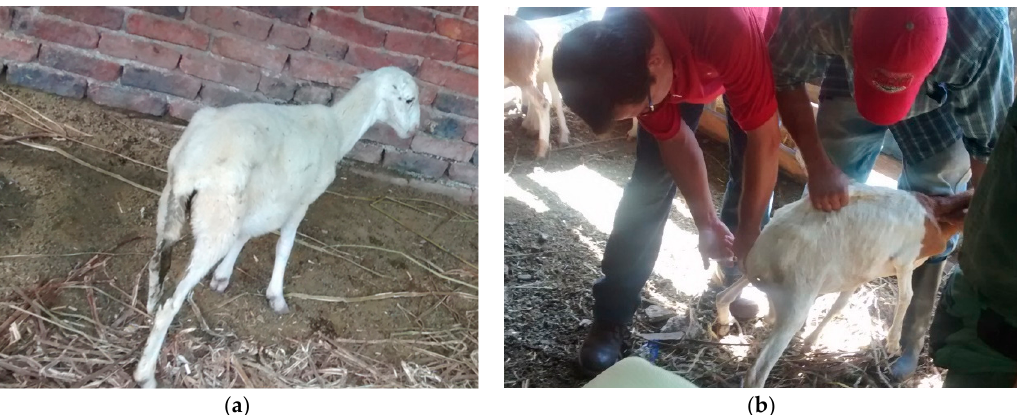
Figure 5. Sheep affected by hypovitaminosis, and parenteral treatment through a supply of vitamin B12 (photos courtesy of Dr. JJ Bustamante). ( a ) Cachectic sheep with signs of diarrhea, ( b ) Parenteral application of vitamin B12.